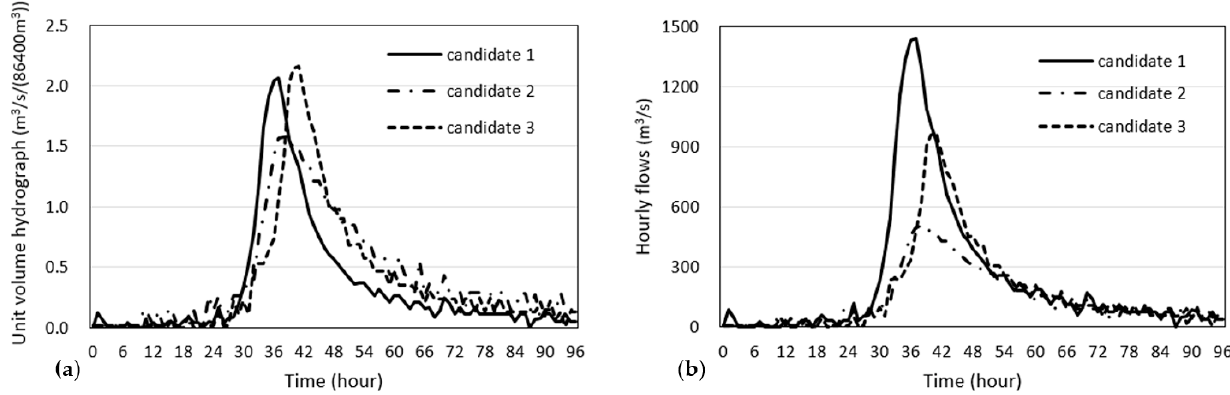
Figure 6. Candidates of the observed hourly unit volume and actual hydrographs at the Imha-dam. ( a ) unit volume hydrograph; ( b ) actual hydrograph.